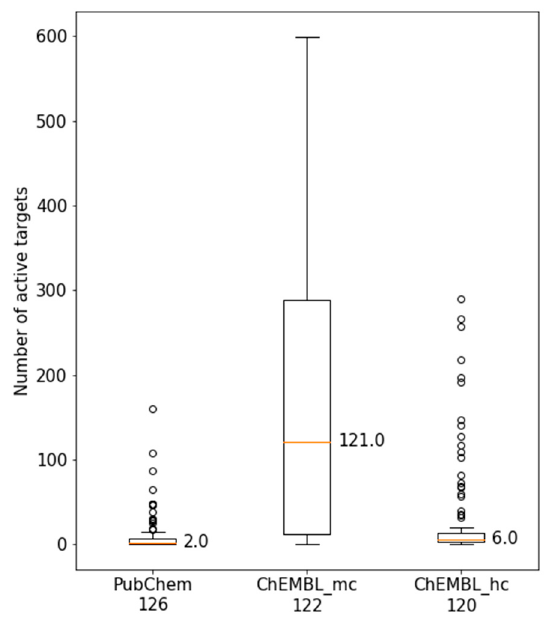
Figure 3. Comparison of multitarget ligand (MTL) target annotations. Boxplots report the distributions of active targets of MTLs on the basis of PubChem or ChEMBL medium confidence (mc) and high confidence (hc) activity data (see Materials and Methods for details). The number of MTLs in PubChem and ChEMBL slightly varied and is reported below each plot.